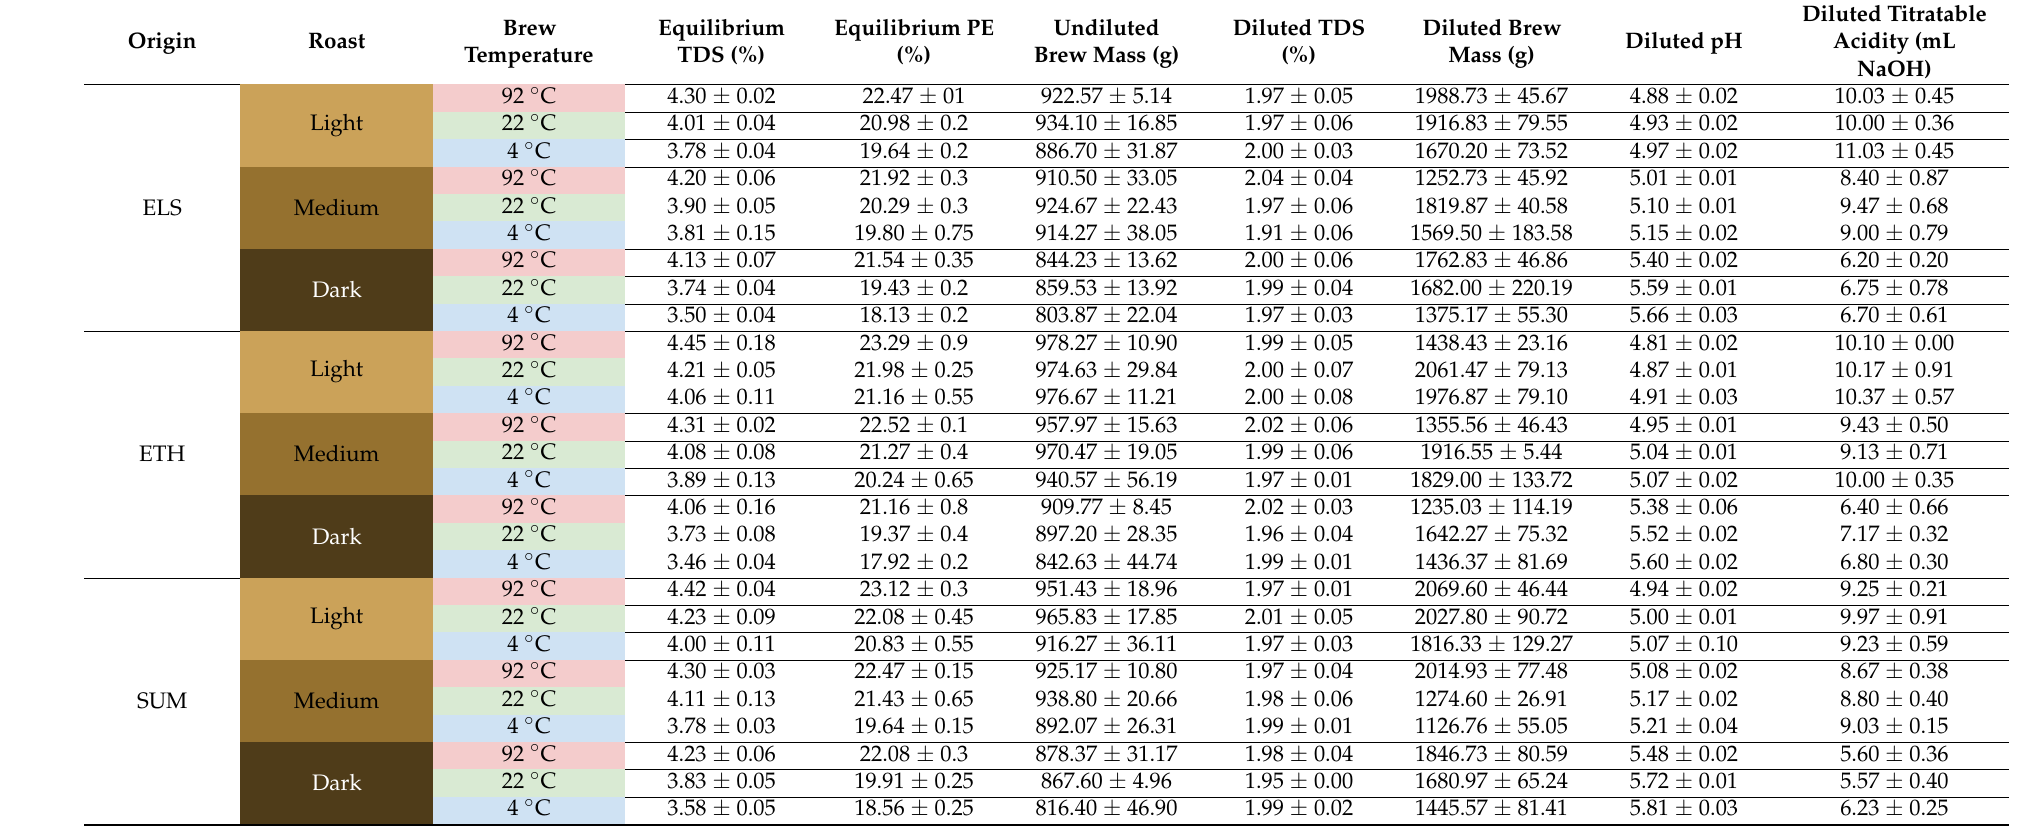
Table 1. Means and standard deviations for all physical and chemical measurements for each sample in the sensory